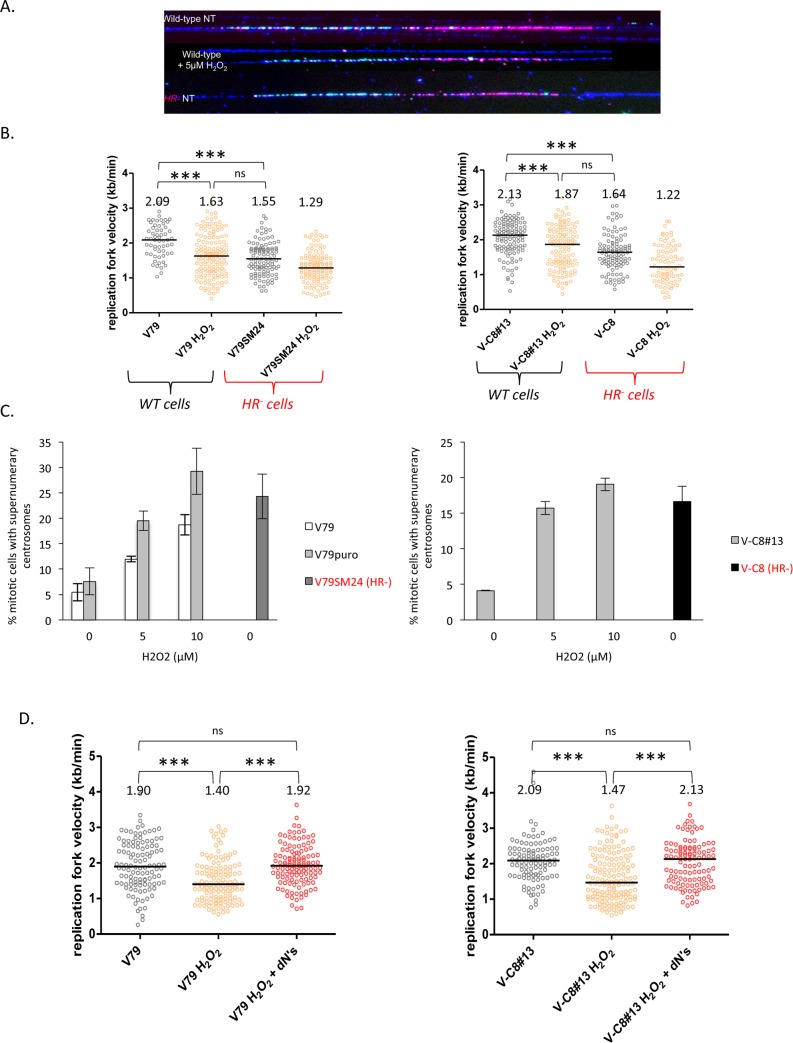
Impact of H2O2 on the genome-wide replication speed.A/ Examples of molecular combing fibers. B/ RF speed distribution in V79 cells and derivatives (left) and V-C8 cells and derivatives (right) after exposure to H2O2 (5 μM). The median values are represented as horizontal black lines. p-value: *P < 0.05; **P < 0.01; ***P < 0.001; ns: not significant. Approximately 100–120 fibers were scored per condition. C/ Impact of H2O2 on MECs in V79 cells and derivatives (left) and V-C8 cells and derivatives (right). The mean value +/- s.d. was calculated from at least three independent experiments. In total, 150 mitoses were scored for each experiment and condition. D/ The effects of the addition of dNs on the replication fork speed after exposure to H2O2. The replication fork speed distribution in V79 cells and derivatives (left) and V-C8 cells and derivatives (right) is presented. The numbers correspond to the median replication speed. The median (black lines) and p-values are indicated in the histogram (*P < 0.05; **P < 0.01; ***P < 0.001). ns: not significant. 100 to 145 fibers were scored per condition.